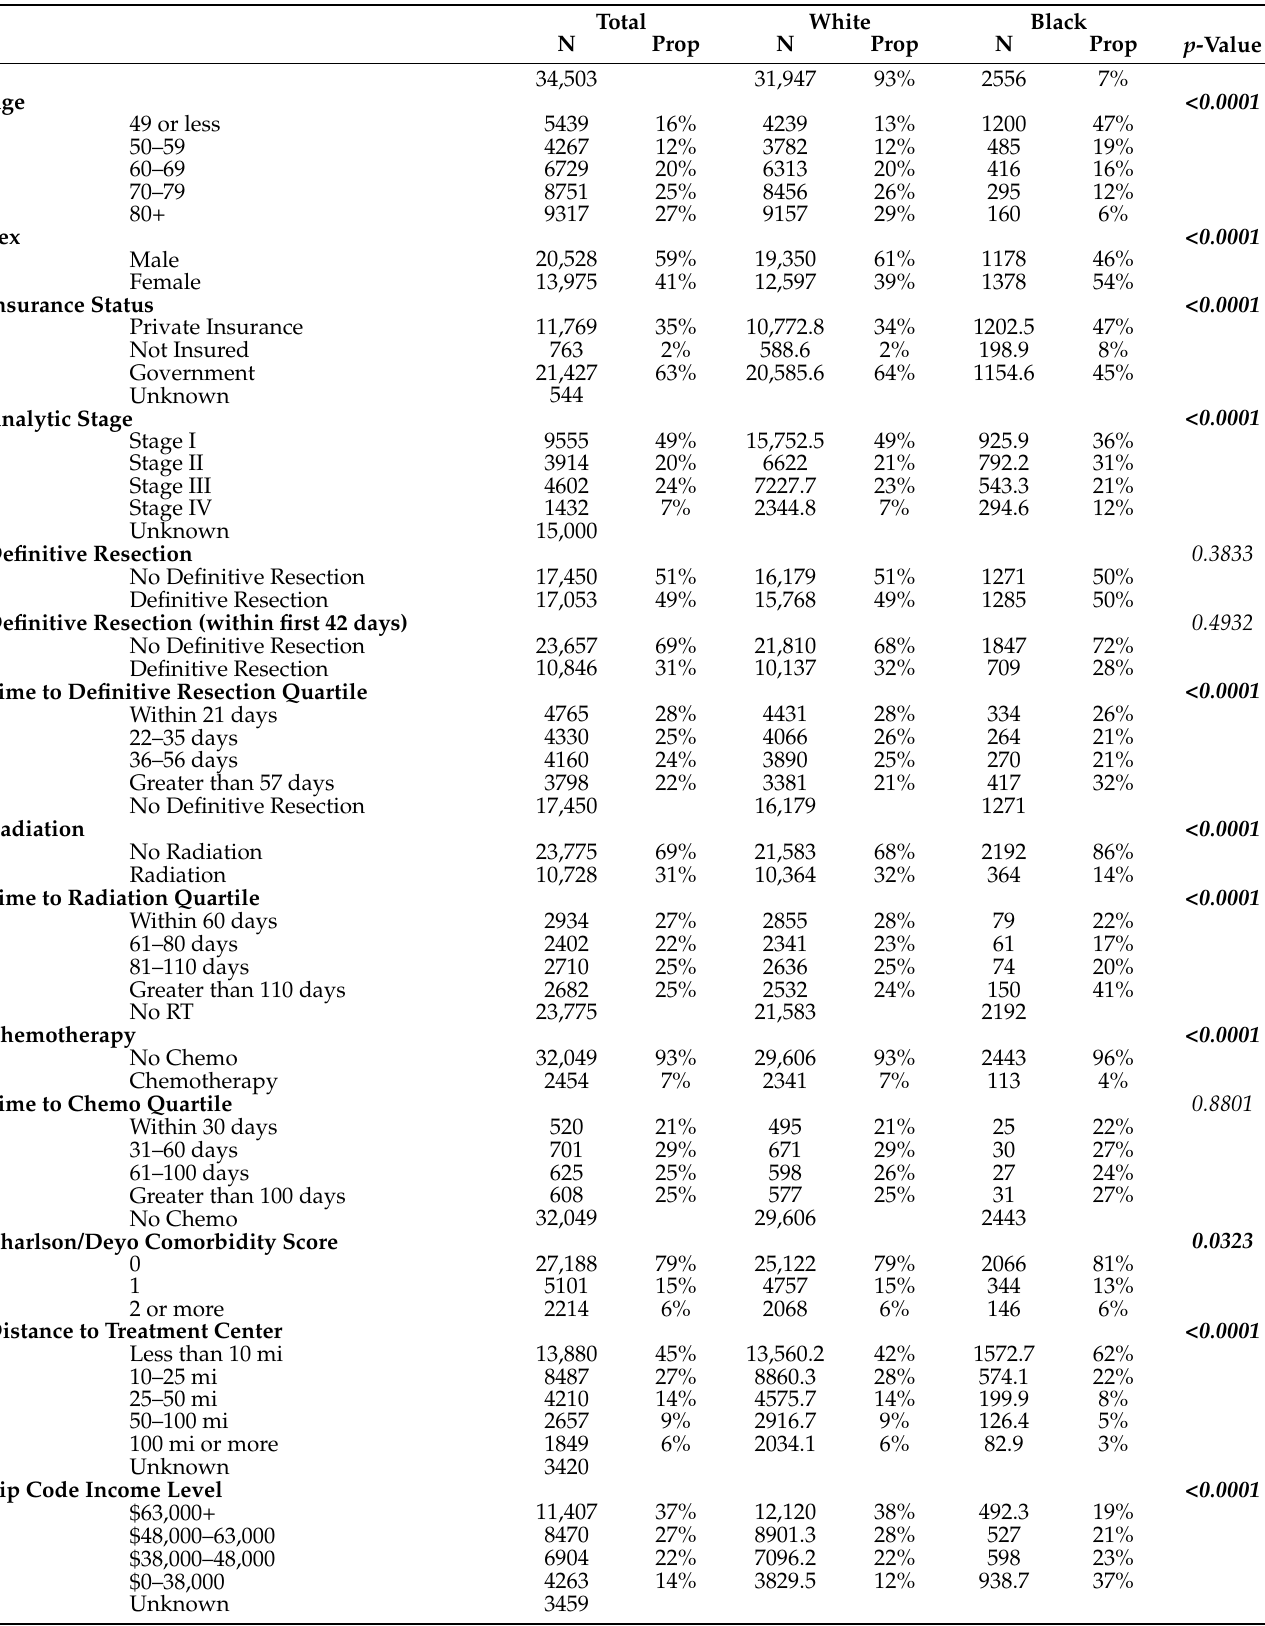
Table 1. Cohort characteristics by